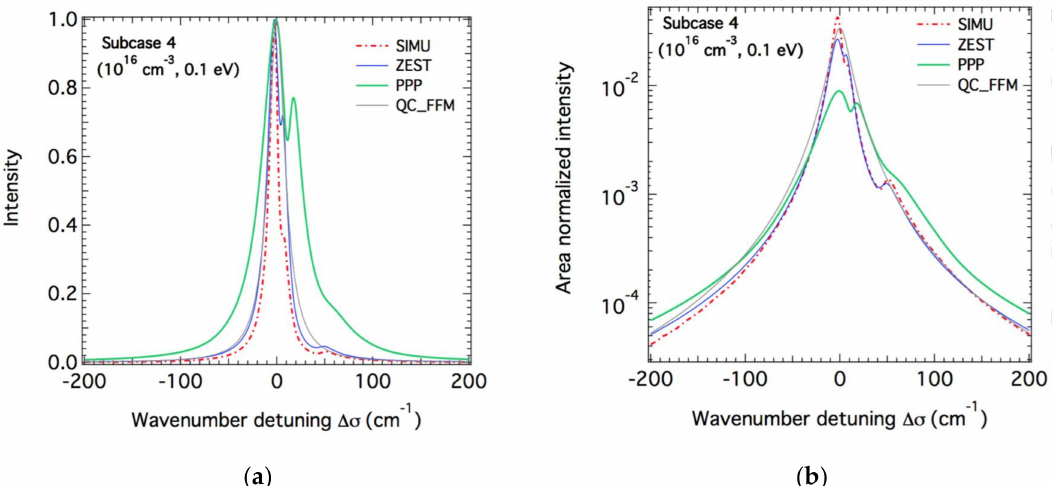
Figure 4. Theoretical Stark profiles of the He I 492 nm line calculated for a helium plasma with an electron density of 10 16 cm − 3 and a temperature of 0.1 eV for both plasma He + ions and electrons. The profiles are centered at 492 nm and expressed as wavenumbers in cm − 1 units. Blue: ZEST, green: PPP, grey: QC_FFM, red dot-dashed: SimU. ( a ) Linear scale. ( b ) Same profiles but area normalized and plotted using a semi-logarithmic scale.